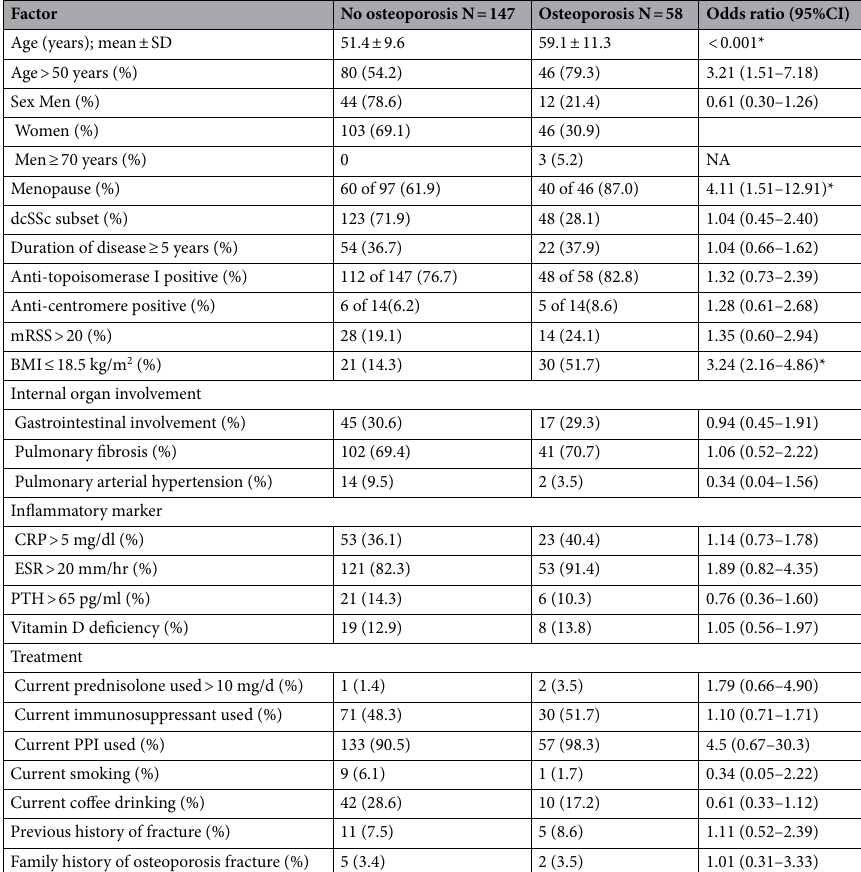
Table 2. Clinical factors associated with osteoporosis at the lumbar spine. CI Confidence interval, dcSSc Diffuse cutaneous systemic sclerosis, mRSS Modified Rodnan skin score, CRP C-reactive protein,